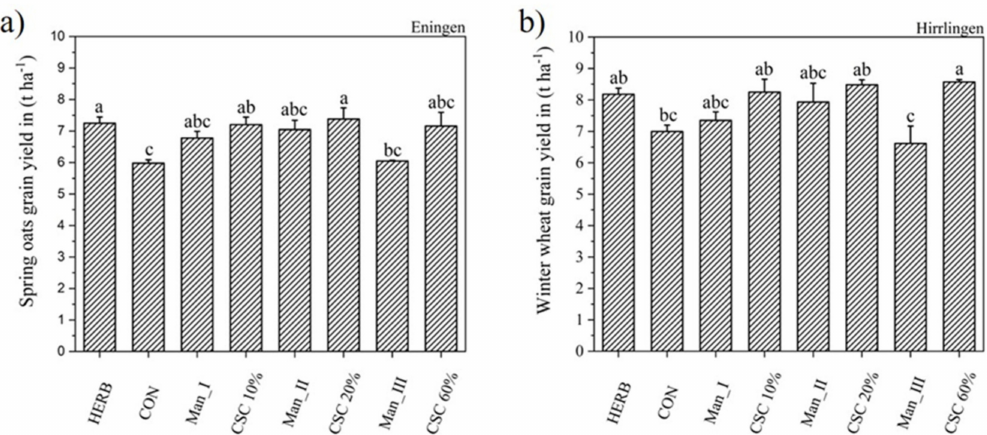
Figure 5. Grain yield (t ha − 1 ) of spring oats in Eningen, p = 0.0039 ( a ) and winter wheat in Hirrlingen, p = 0.0032 ( b ) in 2020. Means with the same letter were not significantly different according to HSD-test at α ≤ 0.05. HERB = herbicide application, CON = untreated control, conventional intensity (Man_) I, II and III = tine angle 10 ◦ , 40 ◦ and 70 ◦ , Crop soil cover (CSC) 10, 20, and 60% = plant burial by 10, 20 and 70% soil. The error bars shows the standard